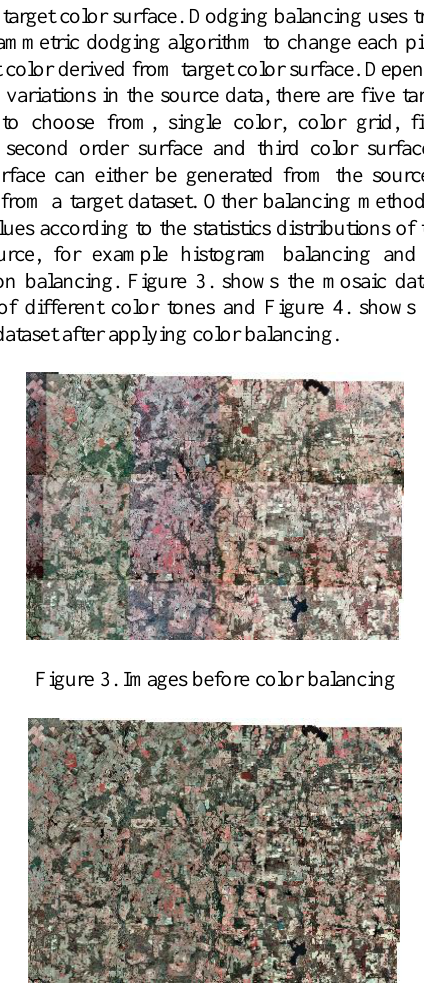
Figure 4. Images after color